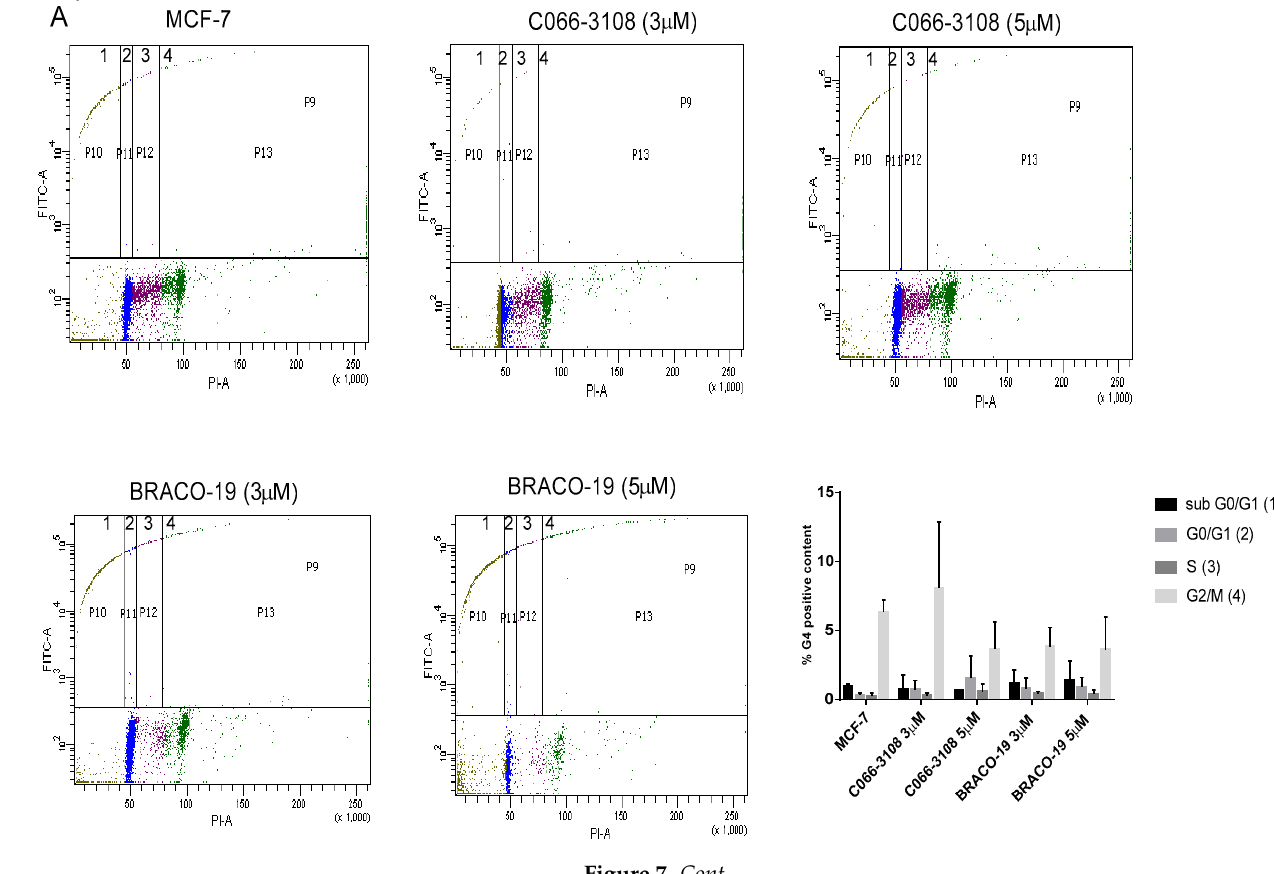
Figure 7. Cont . Figure 7.